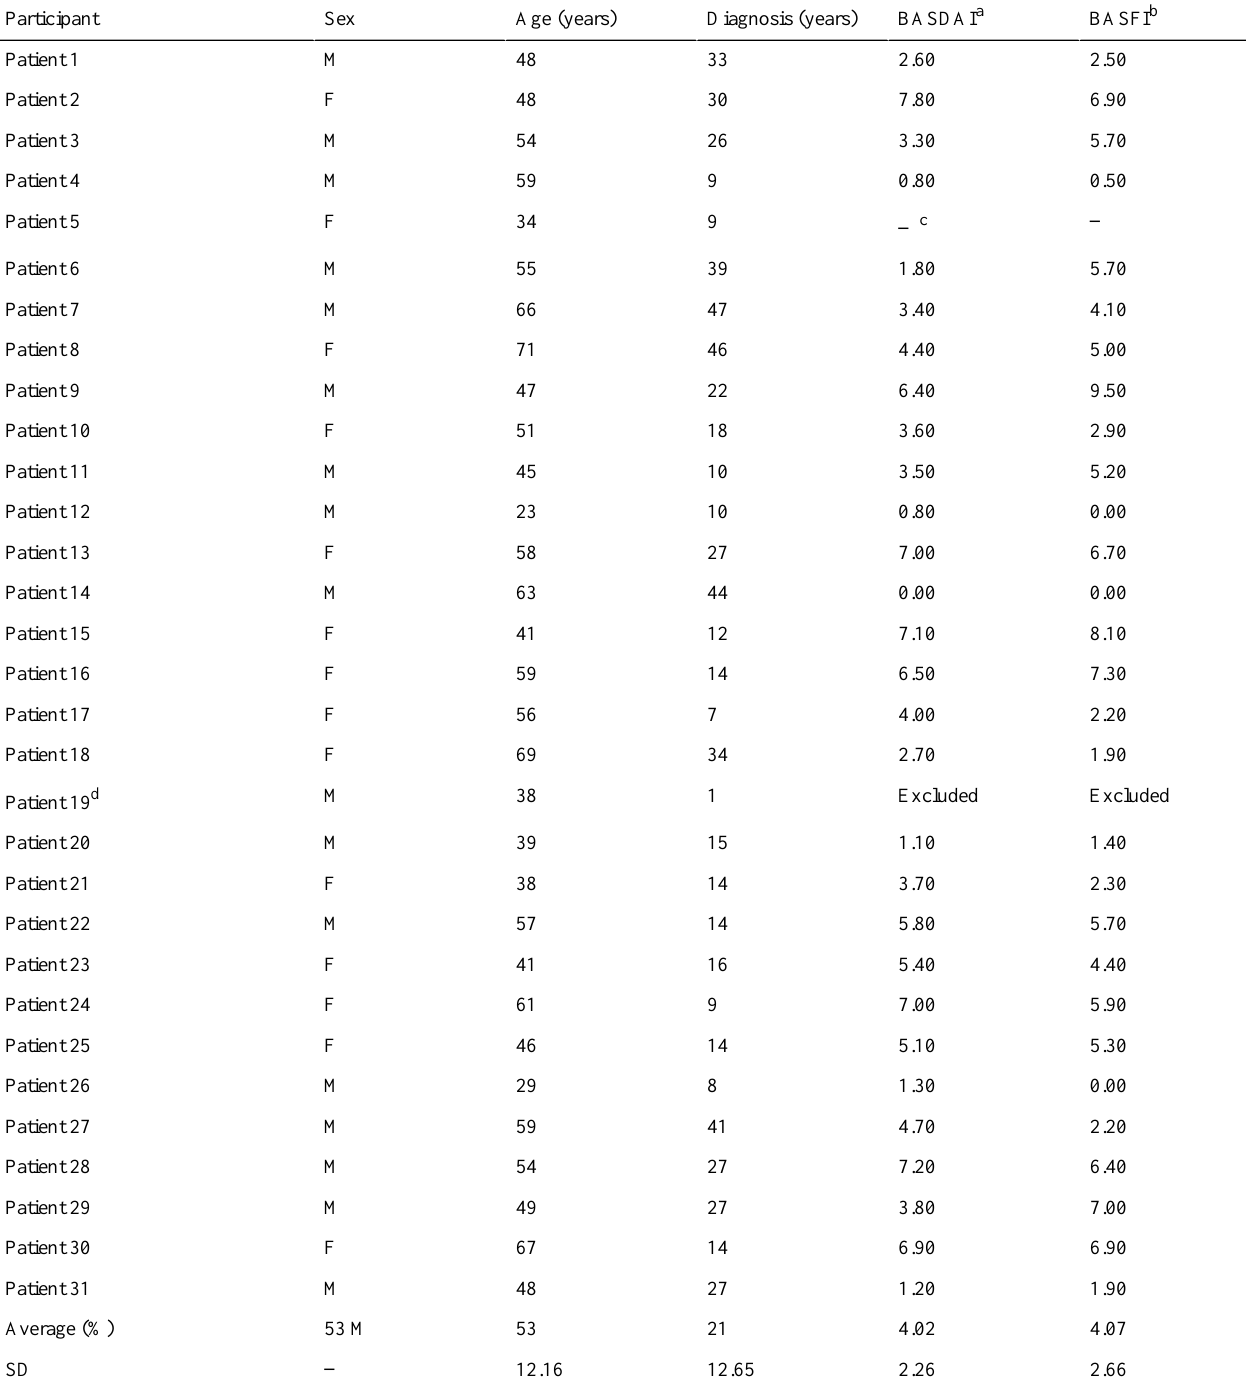
Table 1. Patients participating in interviews and focus groups, with gender, age, and disease-related scores. Scores varied from 0.00 to 7.20 (out of a possible 0 to 10) on the Bath Ankylosing Spondylitis Disease Activity (BASDAI) (mean 4.02 [SD 2.26]) and 0.00 to 9.50 (out of a possible 0 to 10) on the Bath Ankylosing Spondylitis Functional Index (BASFI) (mean 4.07 [SD 2.66]).